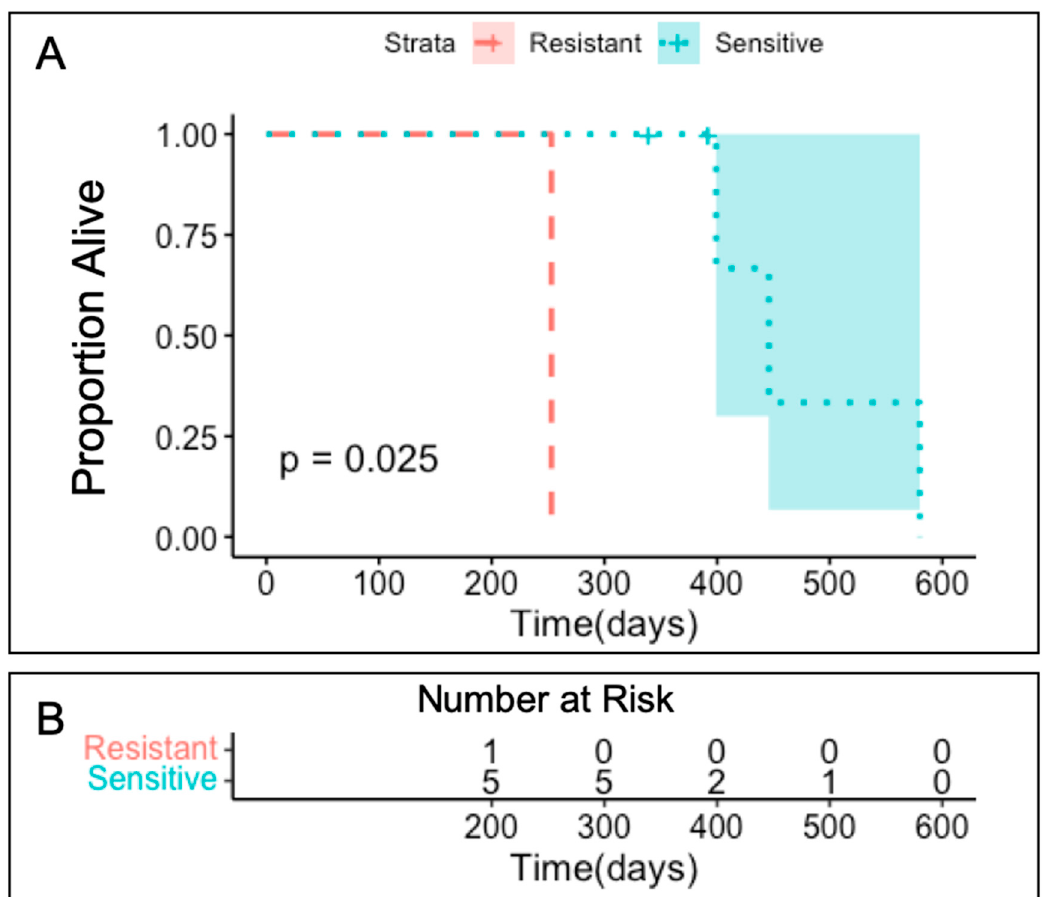
Figure 3. ( A ) Kaplan–Meier Survival plot demonstrating the PFS of enrolled subjects when stratified by carboplatin TO chemosensitivity assay results. Platinum-resistant (red): UK1254. Platinum-sensitive (blue): UK1236, UK1267, UK1393, UK2238, and UK2326. ( B ) Plot demonstrating number of subjects at risk for progression in platinum-resistant and -sensitive groups.